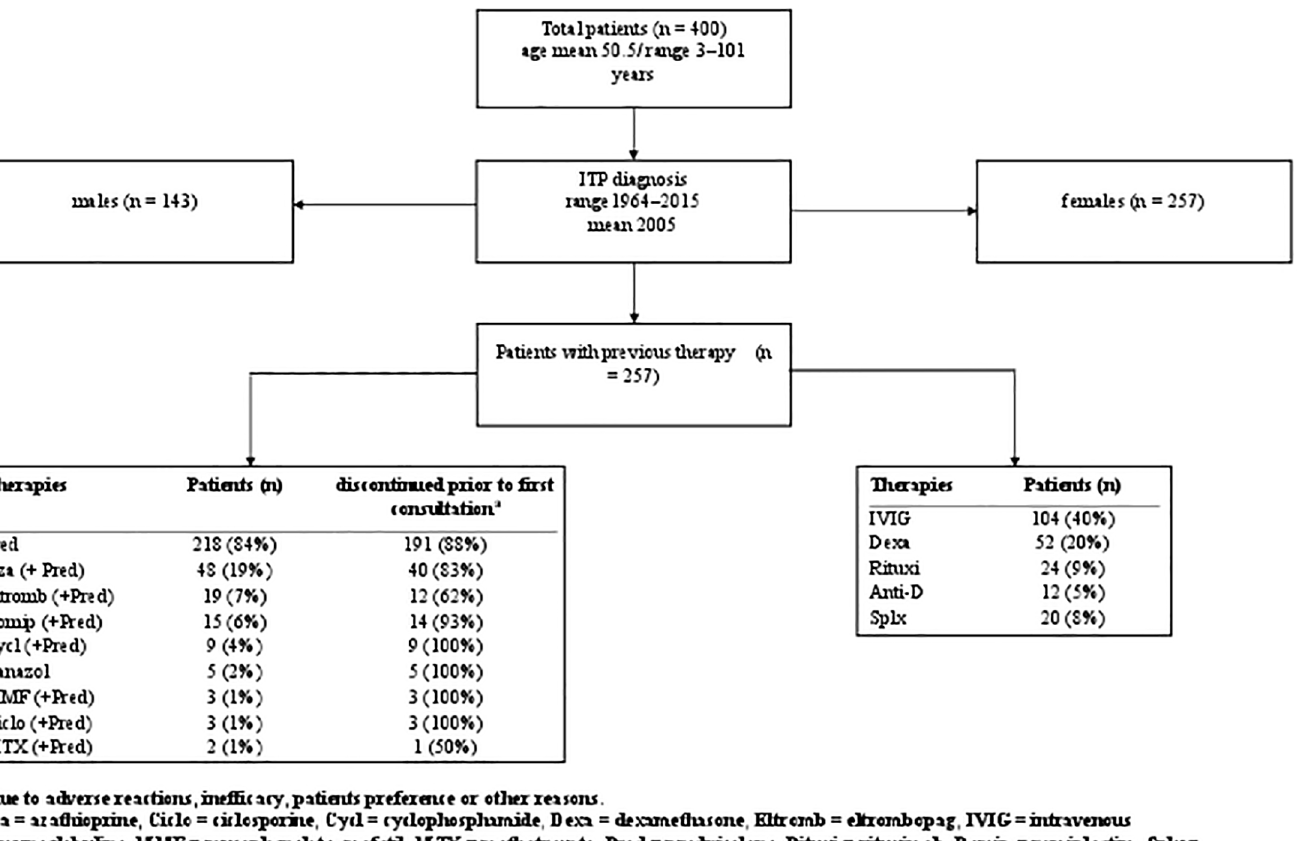
Fig 1. Patient and clinical characteristics.